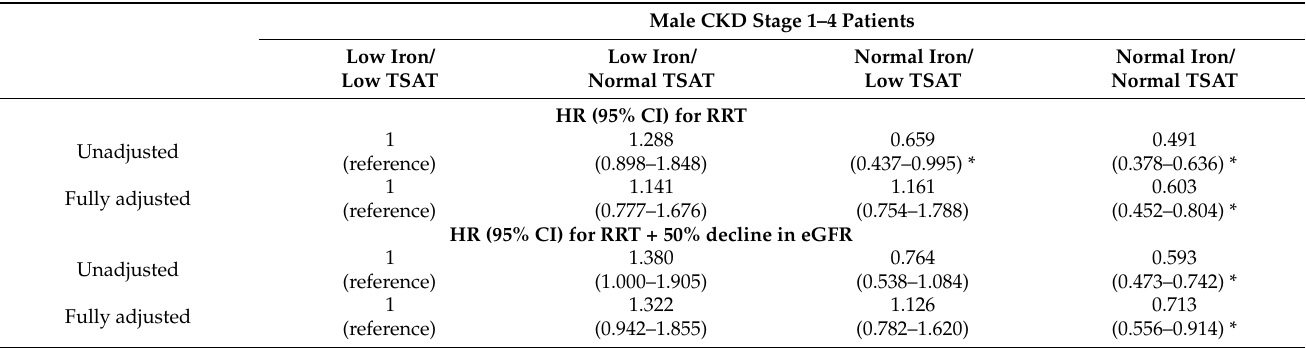
Table 7. Association of “combined TSAT and serum iron” with renal outcomes among male chronic kidney disease stage 1–4